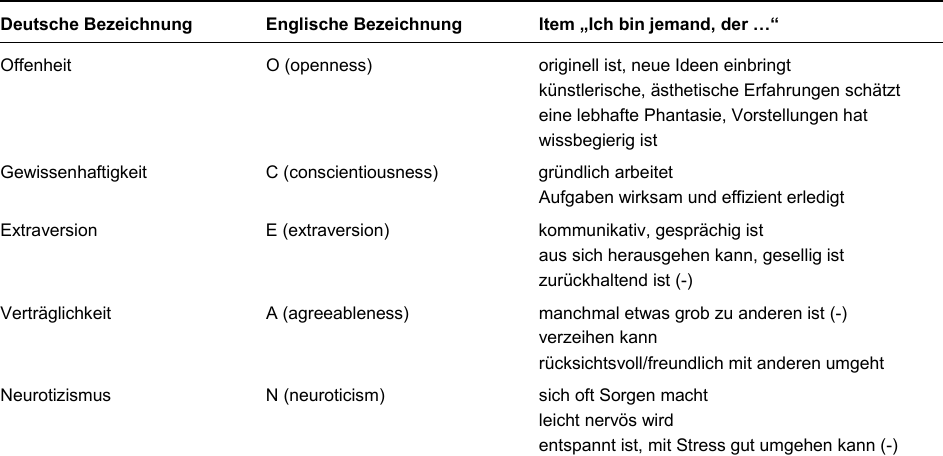
Tabelle 1 : Zuordnung der Items (Frage 93) „Ich bin jemand, der …“ des SOEP- Jugendfragebogens (DIW Berlin/SOEP 2013a) zu den Dimensionen des Big-Five-Modells (deutsche und englische Bezeichnung); (-):